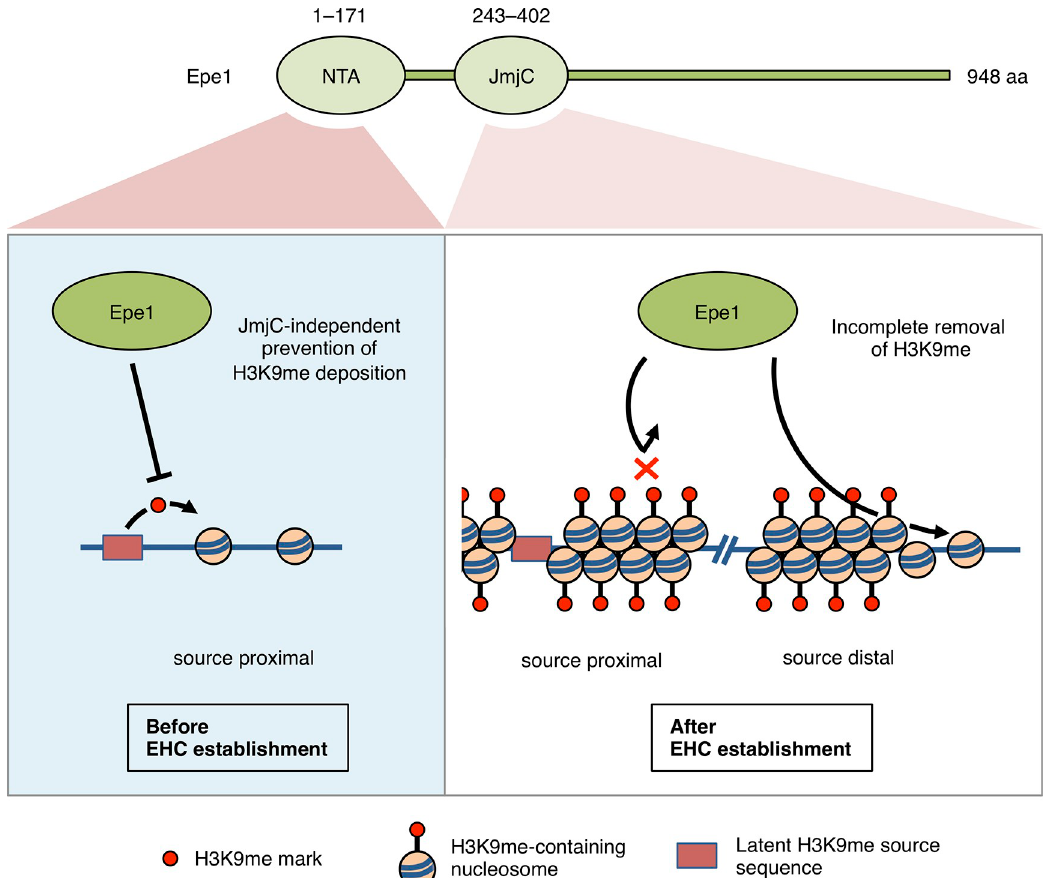
Fig 6. Model of two distinct functions of Epe1 in the suppression of ectopic heterochromatin formation and selective retention of robust ectopic heterochromatin. Before ectopic heterochromatin establishment (left), Epe1 prevents early deposition of H3K9me via a mechanism that involves its N-terminal transcriptional activation (NTA) domain but not its JmjC. After ectopic heterochromatin establishment (right), Epe1 promotes incomplete demethylation of ectopic H3K9me. Epe1 cannot disrupt already-established ectopic heterochromatin near an H3K9me supply source because the source provides H3K9me and counterbalances removal of H3K9me by Epe1, whereas Epe1 can remove the source-distal H3K9me mark in a JmjC-dependent manner. EHC, ectopic heterochromatin. NTA domain, 1–171 amino acid region as identified in this study; JmjC domain, 243–402 amino acid region as assigned in the SMART database